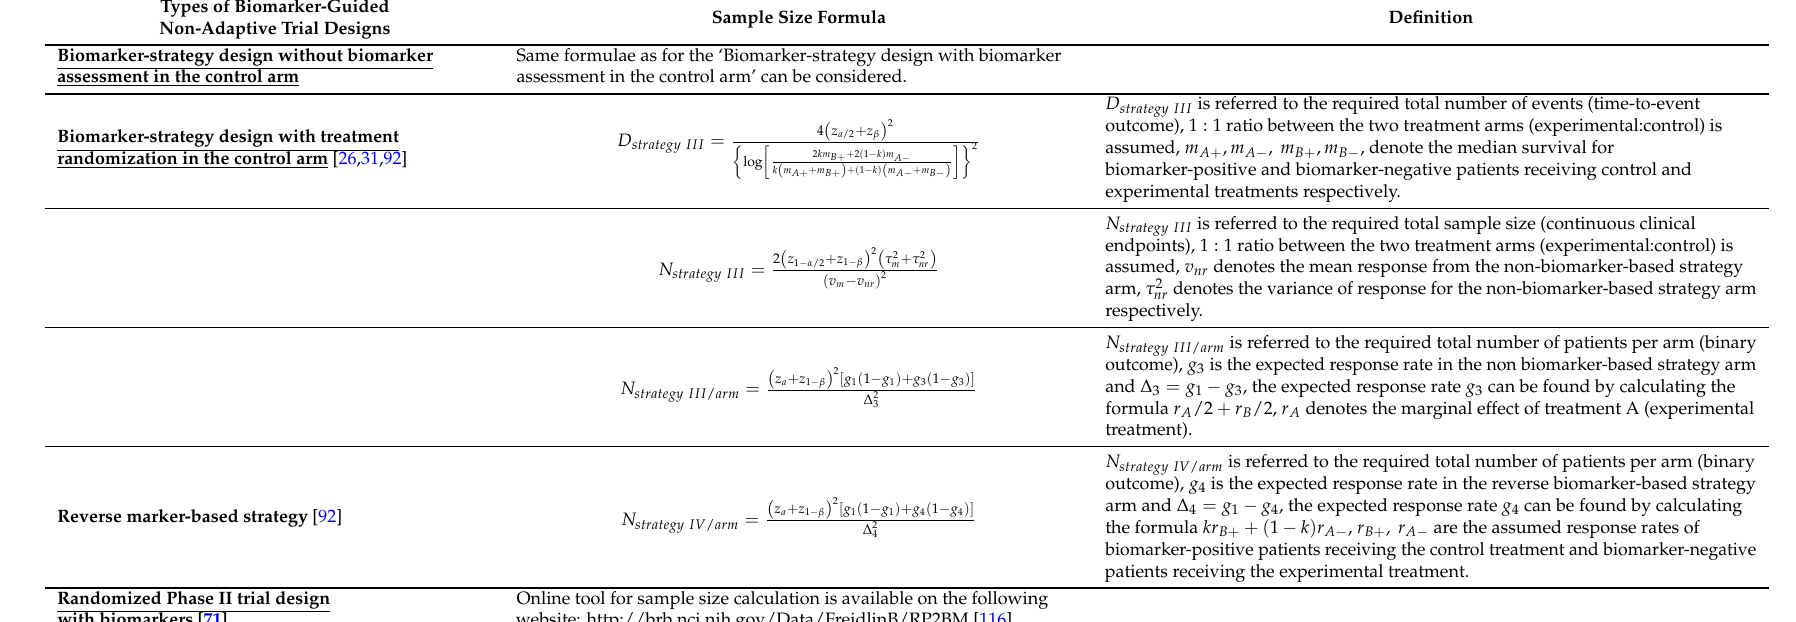
Sample Size Formula